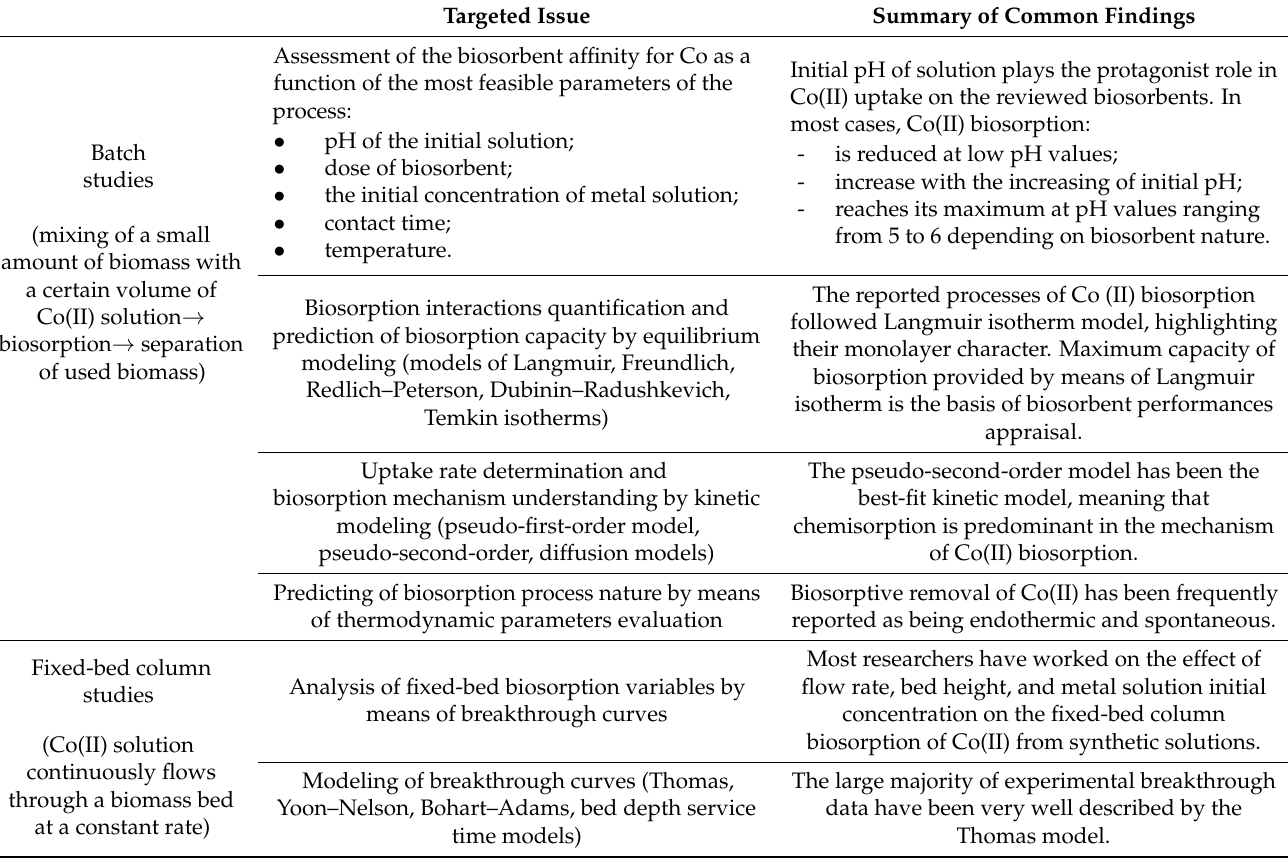
Table 2. Outline of the batch and fixed-bed column studies regarding the removal of Co(II) from aqueous solutions by